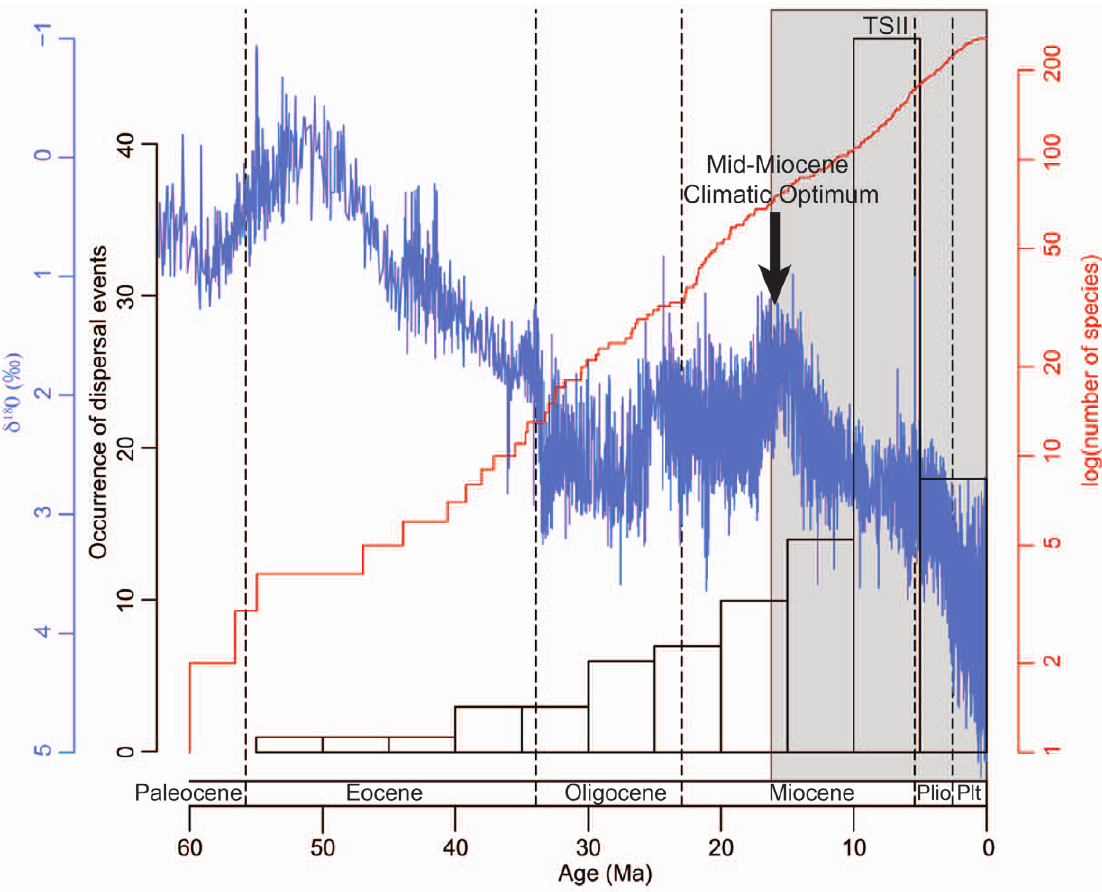
Figure 2. Occurrence of dispersal events through time for Hyacinthaceae inferred by Lagrange. The lineage through time plot (shown in red and based on the PL-dated consensus tree) is displayed with an estimation of climatic oscillations in blue (estimated from the variation of O 18 concentration through time [54]). doi:10.1371/journal.pone.0039377.g002 PLoS ONE |